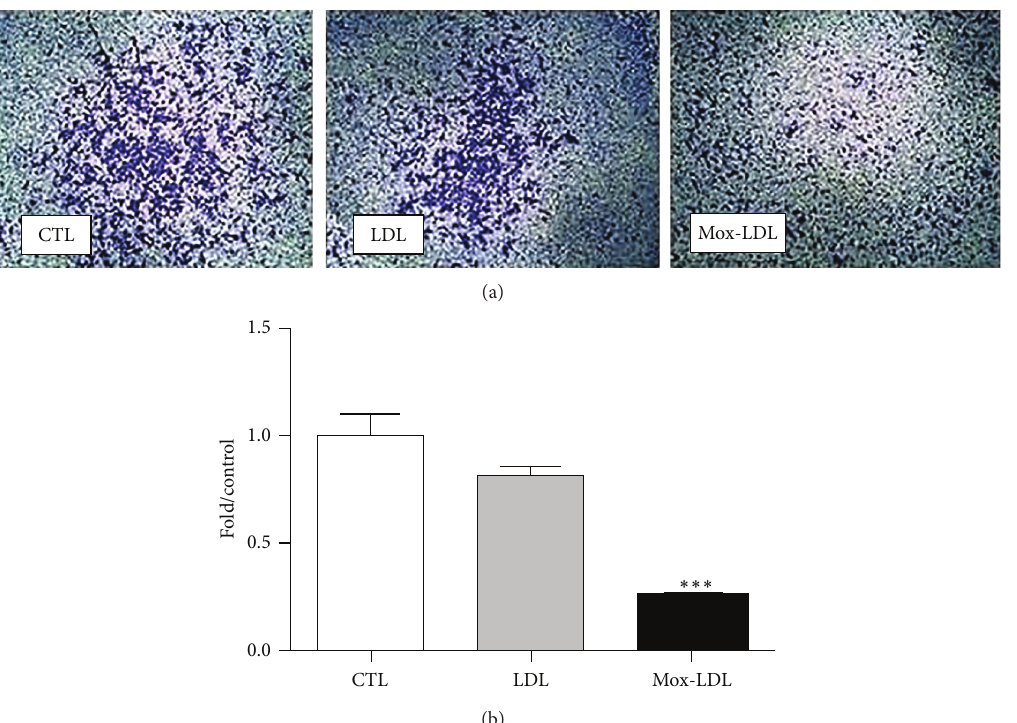
Figure 4: The effect of Mox-LDL treatment on HUVEC cell migration. (a) HUVEC cells which migrated through membranes. HUVEC cells were incubated for 24 hours in culture medium supplemented with mock medium, native LDL, or Mox-LDL and then seeded onto the membrane in the upper chamber of a modified Boyden chamber in conditions inducing the migration to the lower chamber. After 8 hours cells that migrated to the lower membrane side were fixed and stained. The results shown are representative of three independent experiments performed in duplicate. (b) Quantification of (a). Pictures were taken of fixed and stained cells that migrated through the membrane. Cells were counted and numbers of migrated cells were expressed as fold over control untreated cells. Mean ± SEM on 3 independent experiments performed in duplicate. ∗∗∗ 𝑃 < 0.001 versus control (ANOVA, Turkey’s multiple comparison